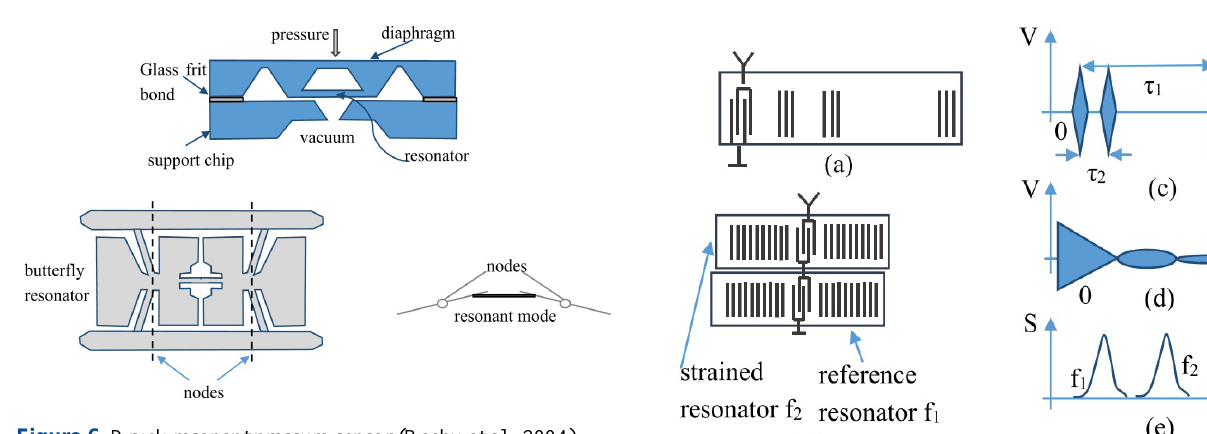
Figure 6. Druck resonant pressure sensor (Beeby et al., 2004).